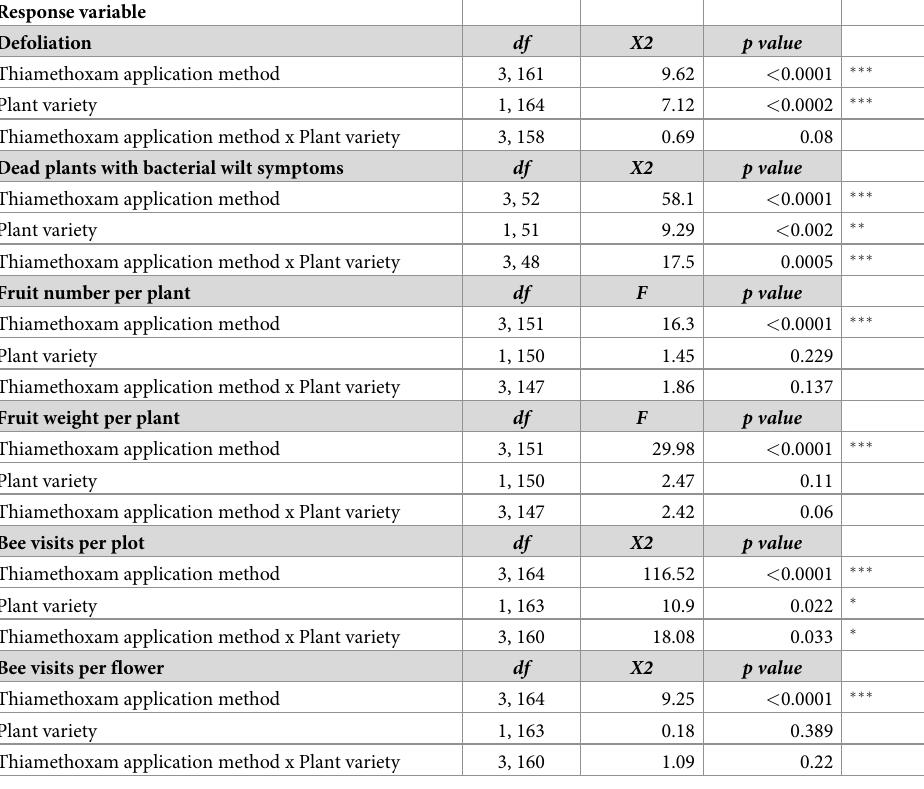
Table 2. ANOVA results for the effect of thiamethoxam application method, plant variety, and their interactions on percentage defoliation, number of dead plants with bacterial wilt symptoms, fruit number, fruit weight, bee visits per plot, and bee visits per flower in squash